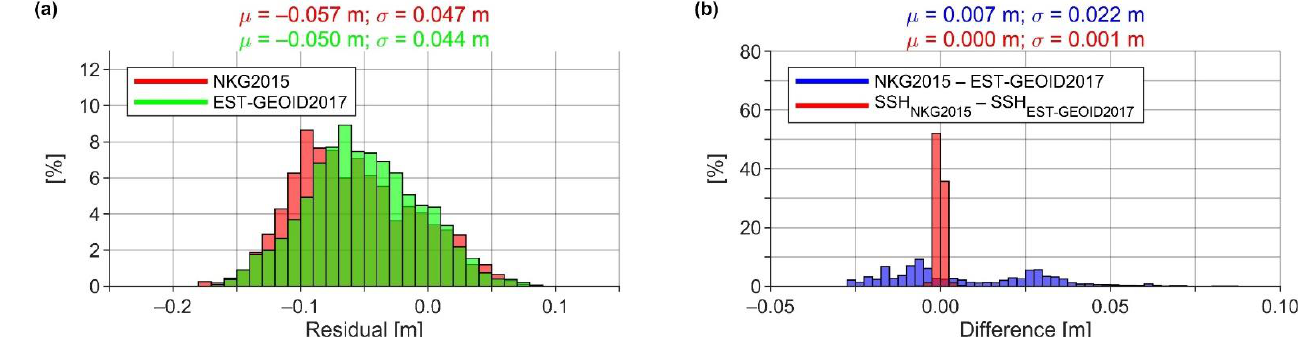
Figure 20. ( a ) Histograms of residuals (all campaigns combined): the impact of geoid model choice, and ( b ) histograms showing differences between the NKG2015 and EST-GEOID2017 models (along the vessel’s routes) and the SSH datasets derived using these models during data processing. The resulting discrepancies are compared in Figure 20a.